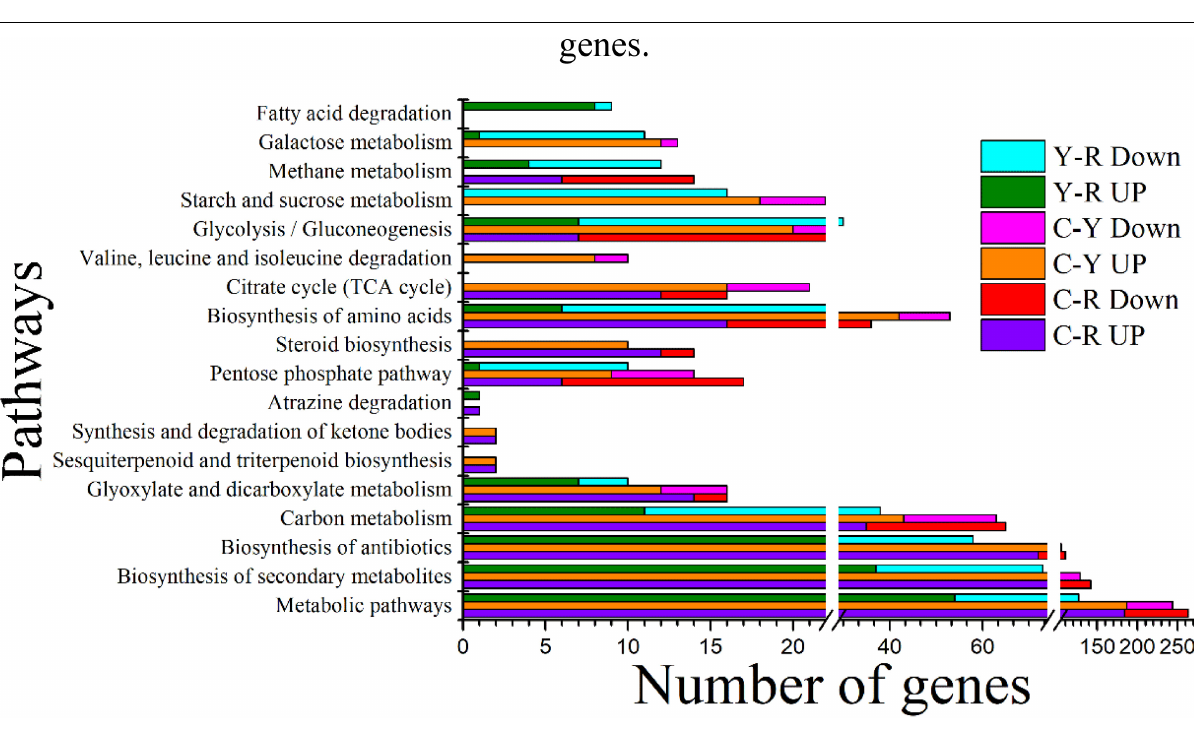
Frontiers in Microbiology |